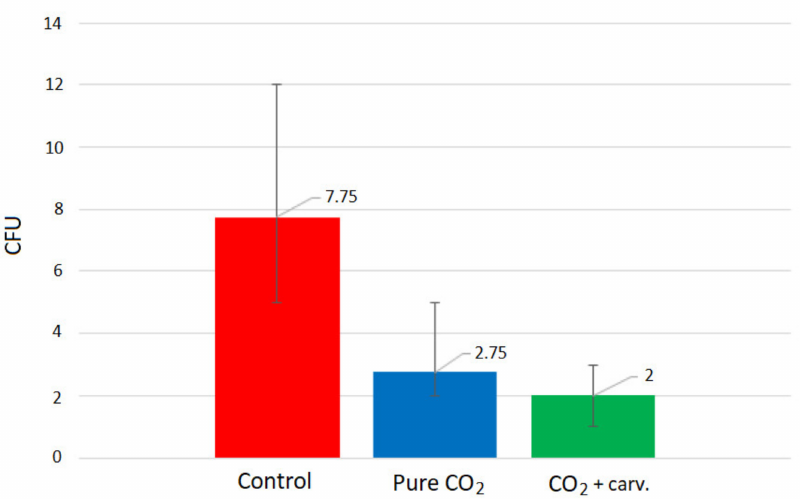
Figure 13. Contamination levels detected without CO 2 insufflation (red), with insufflation using a neat polyamide membrane (blue), and insufflation using a carvacrol-loaded membrane